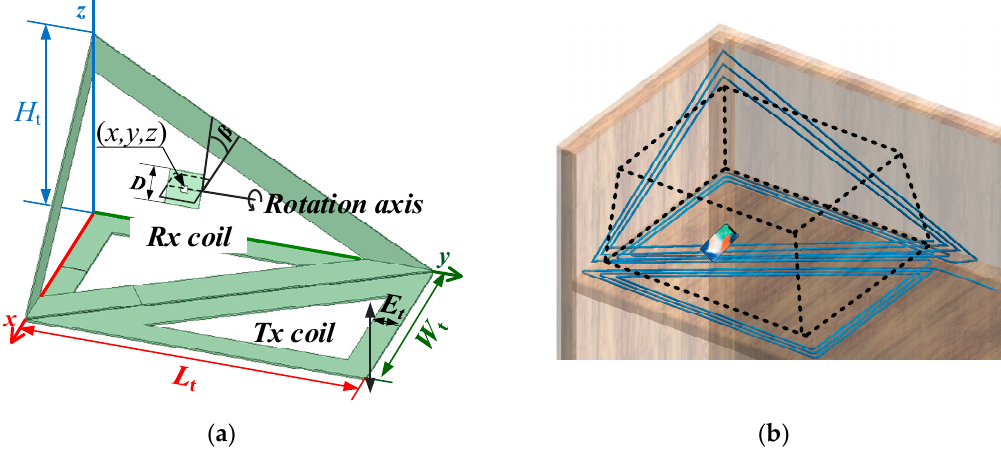
Figure 5. Spatial free-positioning wireless power transfer (WPT) prototype. ( a ) Schematic diagram of the Tx and Rx coils. ( b ) Embedded-design of 3D Tx coil and approximate charging area.